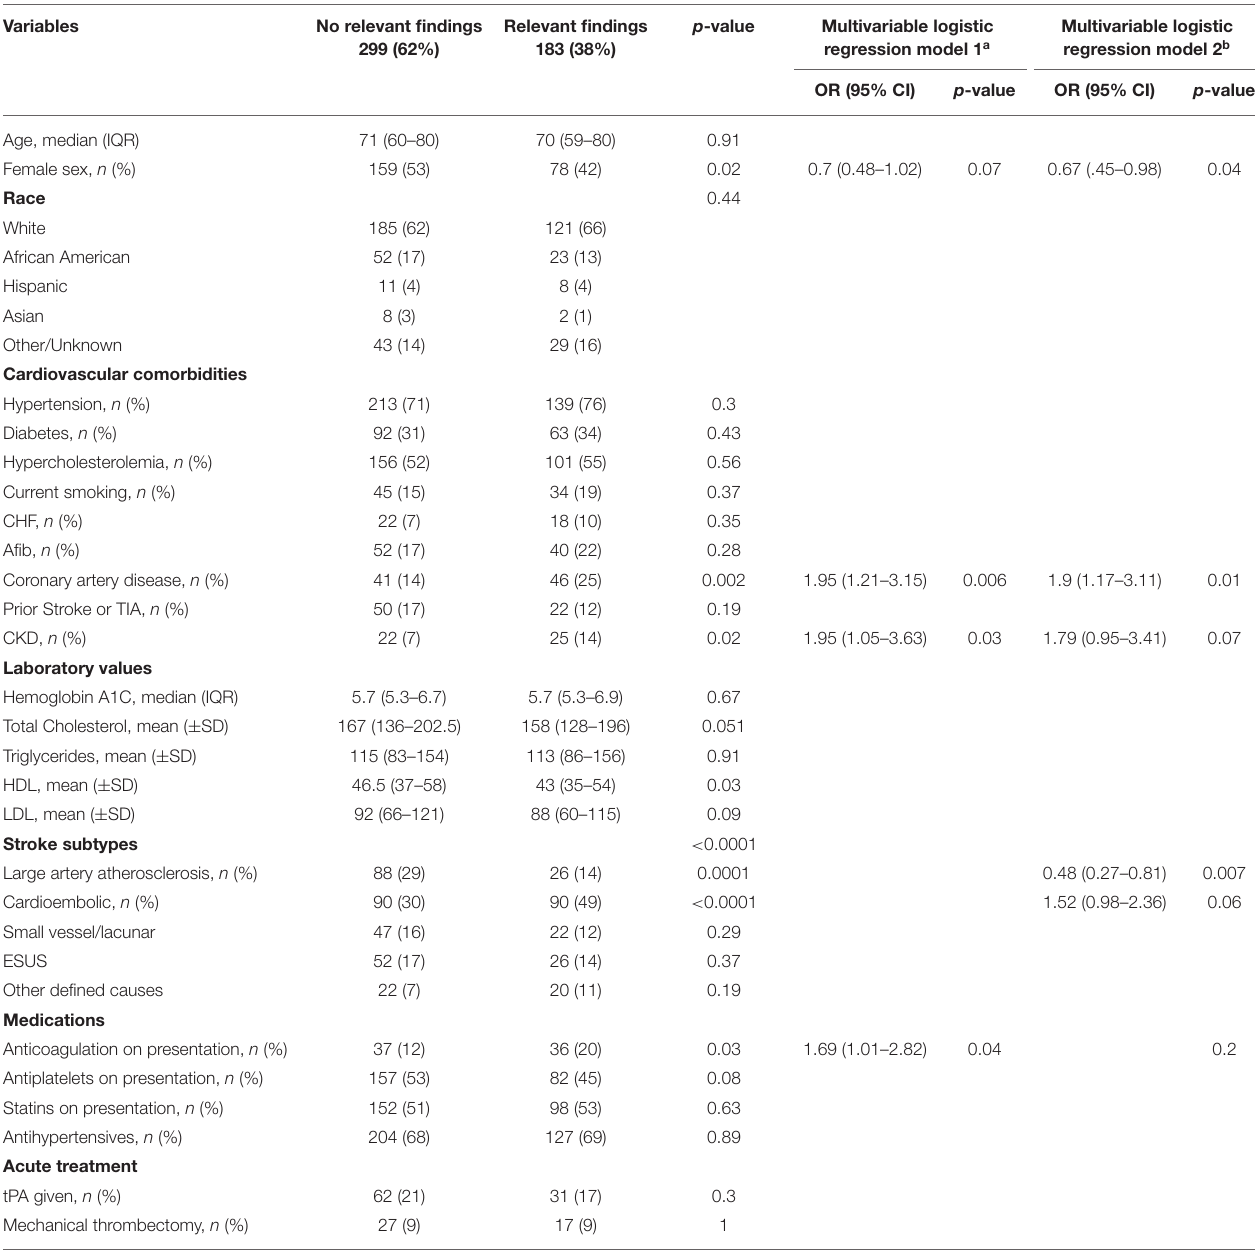
TABLE 2 | Comparisons between patients according to relevant findings on TTE.